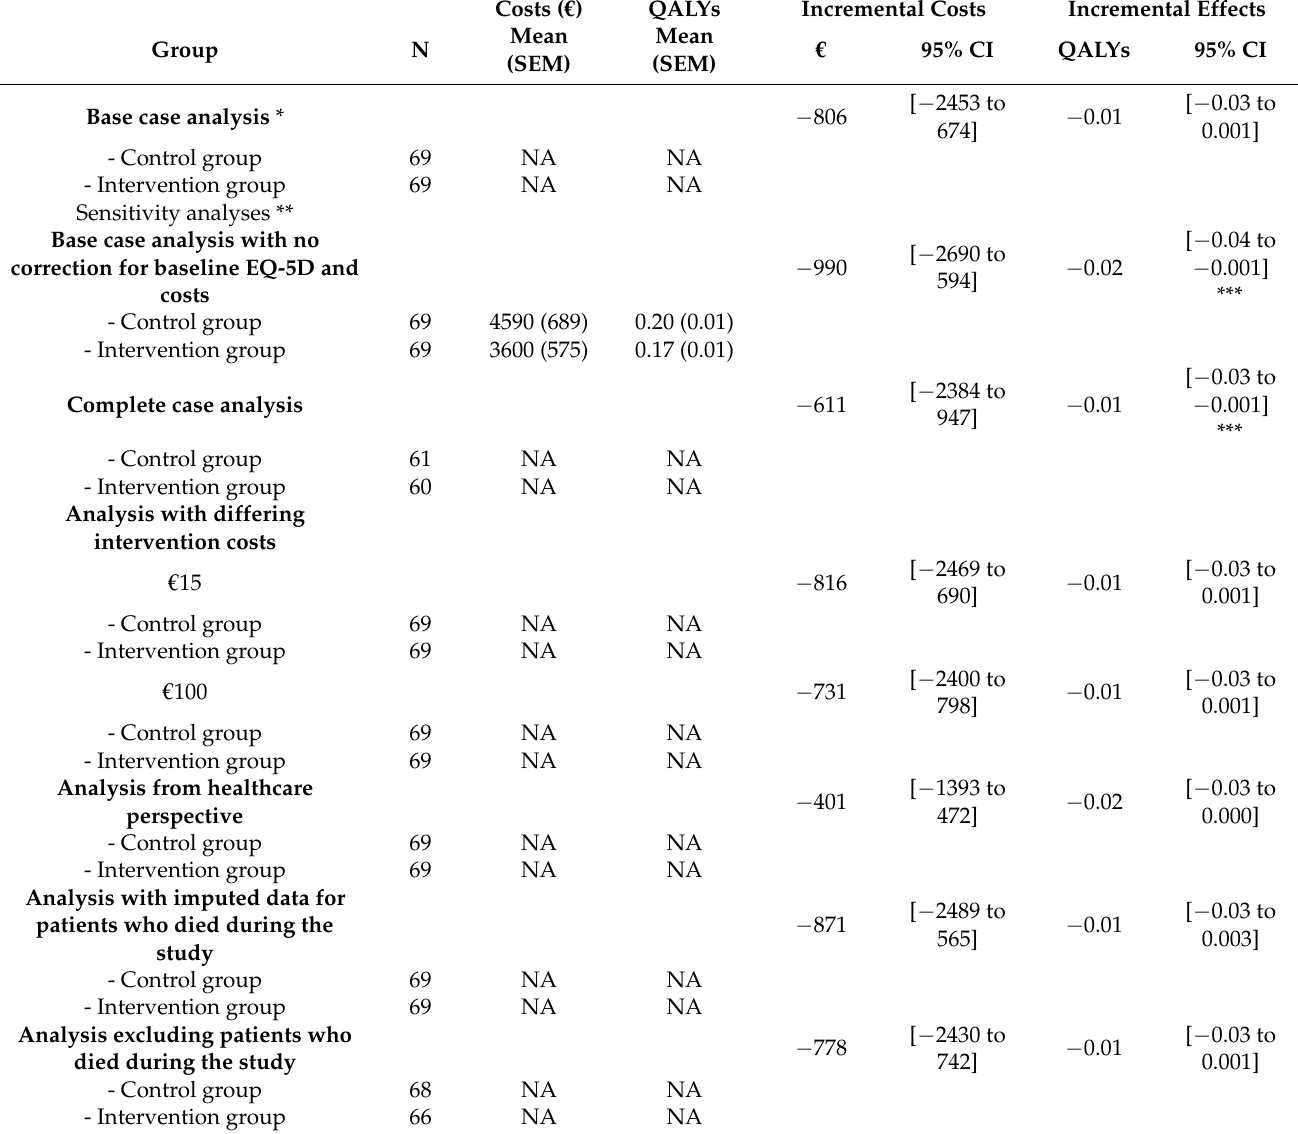
Table 4. Results of the cost-utility analyses (i.e., base case and sensitivity